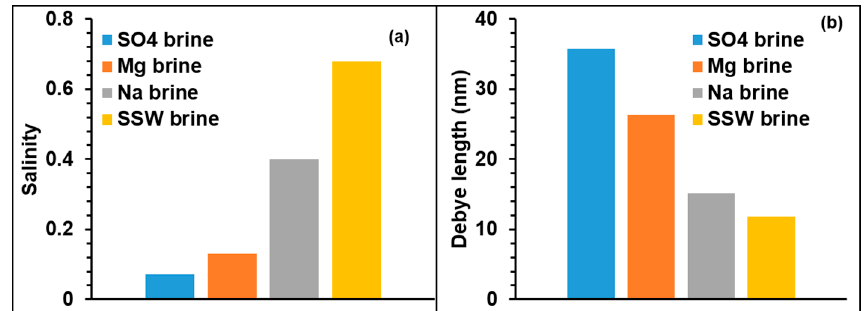
Figure 3. ( a ) Salinity for di ff erent brines; ( b ) Debye lengths for di ff erent brines.